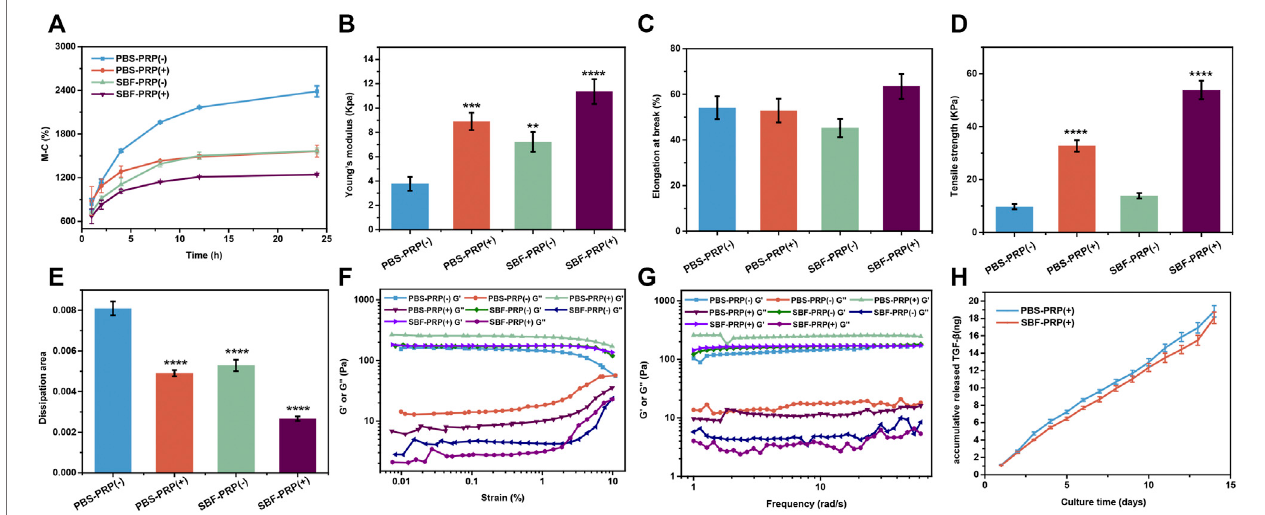
FIGURE 3 | Properties of IPN M-ALG/PEG hydrogels. (A) Swelling rate at different time from 1 to 24 h. (B) Young ’ s modulus, (C) Elongation in break, (D) Tensile strengthand (E) dissipationareaofIPNM-ALG/PEGhydrogels. (F) G ′ andG ″ oftheIPNM-ALG/PEGhydrogelsmeasuredinastrainsweepexperiment(from0.1to10% strain, 6.28 rad s − 1 ) at room temperature. (G) G ′ and G ″ of the IPN M-ALG/PEG hydrogels measured in a frequency sweep experiment (from 0.1 to 60 rad s − 1 , 1% strain) at room temperature. (H) TGF- β release in PBS buffer from 0 to 14 days of PRP-IPN